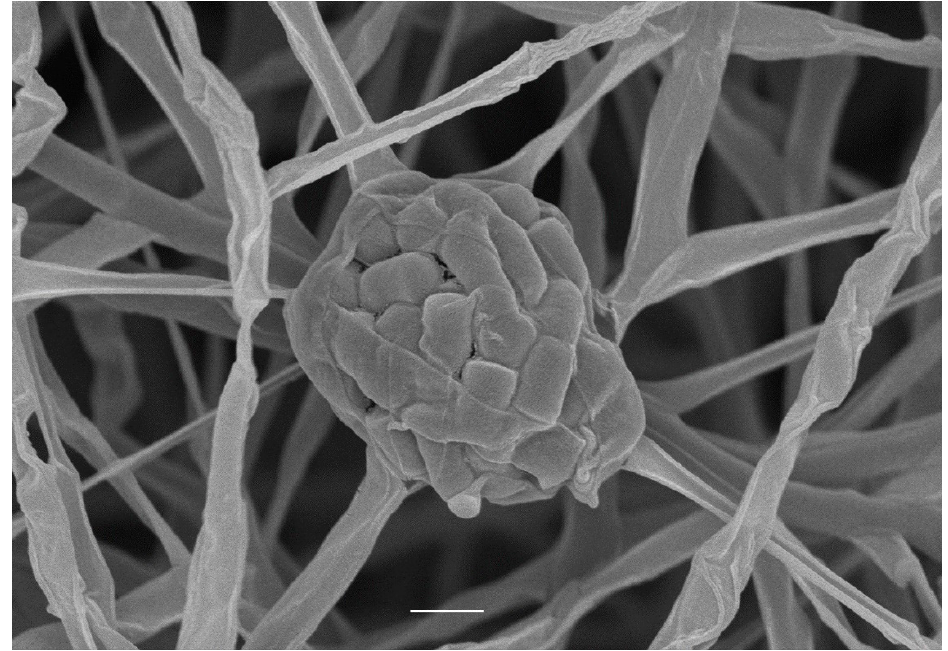
Figure 1. Scanning electron micrograph of strain NEAU-SSA 1 T grown on ISP 3 agar for 6 weeks at 28 °C; Scale bar represents 1 μ m.